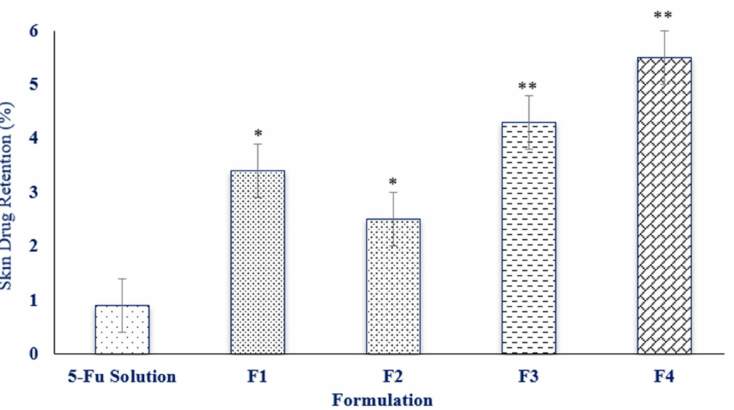
Figure 5. The in vitro skin drug retention profile of the pure 5-FU solution and the 5-FU emulsion formulations (F1, F2, F3, F4), where F4 exhibited significant differences from the rest of formulations, data are expressed as mean ± S.D, n = 3, * denotes ( p < 0.05) and ** denotes ( p < 0.01) statistical significance.